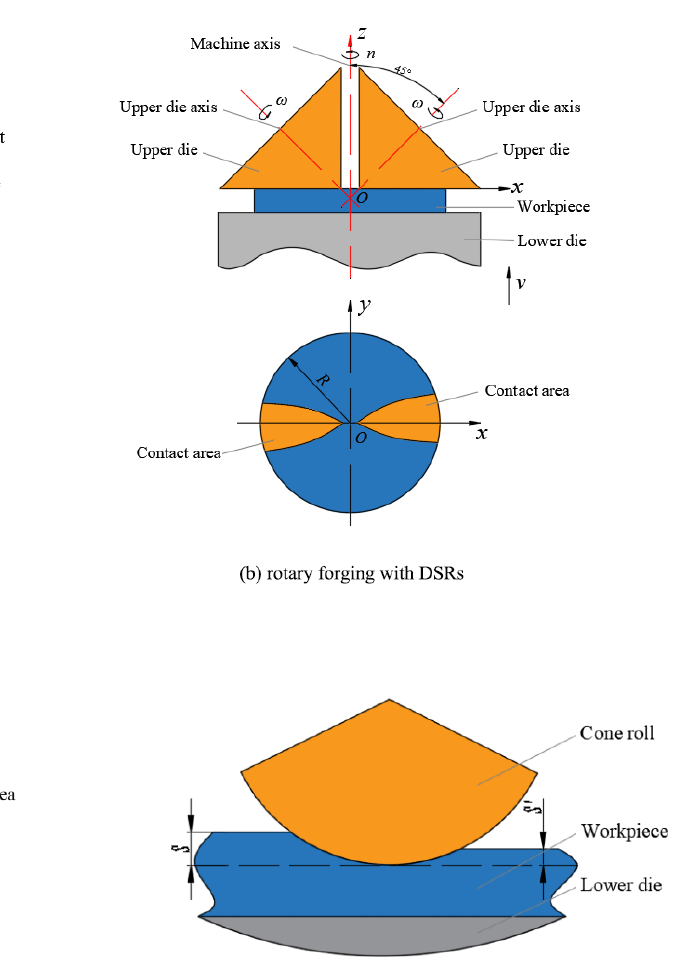
Figure 3. Feed amount per